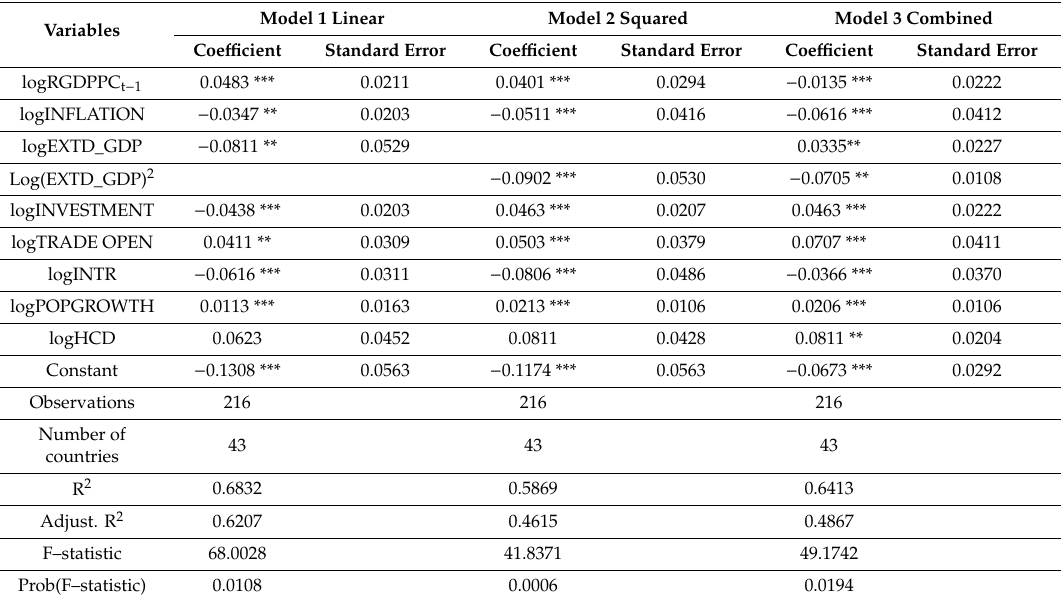
Table 7. Results of the robust